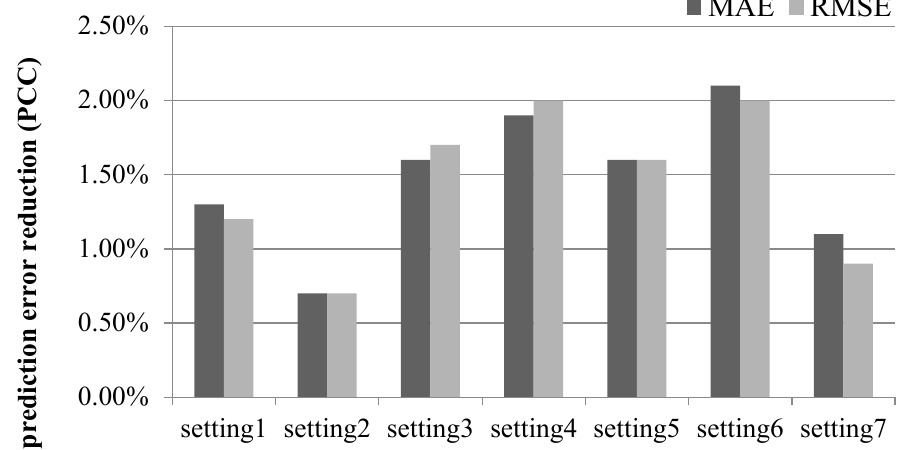
Figure 1. Average prediction error reduction under different bsf factor settings.